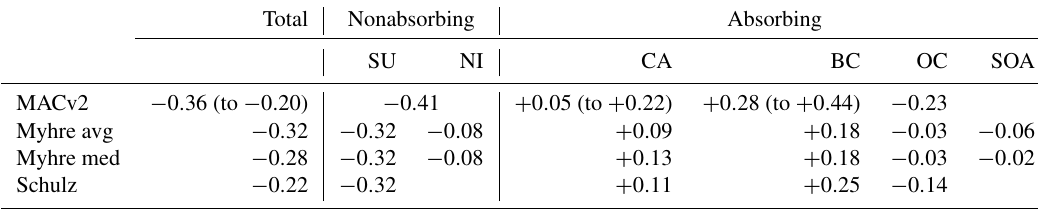
Table G3. Comparisons of present-day aerosol direct radiative forcing (TOA, all sky) in watts per square meter (Wm − 2 ). Total Nonabsorbing Absorbing SU NI CA BC OC SOA MACv2 − 0 . 36 (to − 0 . 20) − 0 . 41 + 0 . 05 (to + 0 . 22) + 0 . 28 (to + 0 . 44) − 0 . 23 Myhre avg − 0 . 32 − 0 . 32 − 0 . 08 + 0 . 09 + 0 . 18 − 0 . 03 − 0 . 06 Myhre med − 0 . 28 − 0 . 32 − 0 . 08 + 0 . 13 + 0 . 18 − 0 . 03 − 0 . 02 Schulz − 0 . 22 − 0 . 32 + 0 . 11 + 0 . 25 − 0 .